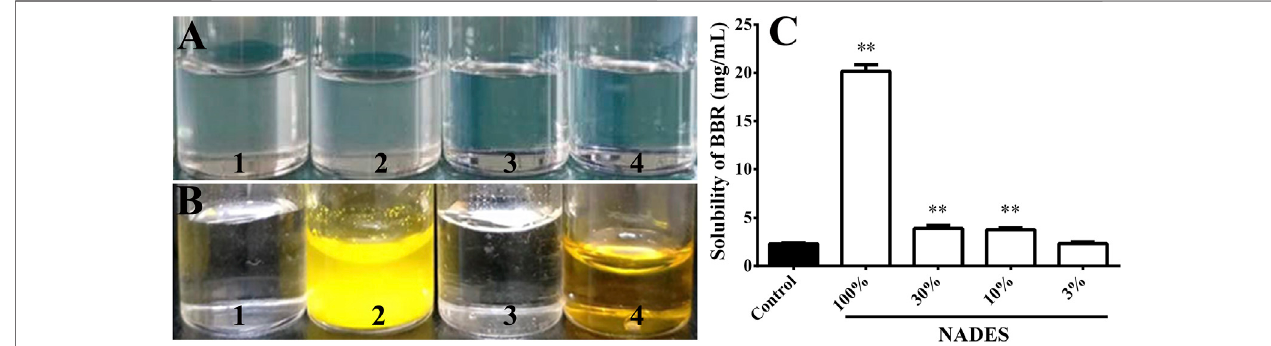
FIGURE2| Stabilityanddissolvingcapacityofthepreparednaturaldeepeutecticsolvents(NADESs)(Mean ± SD, n (cid:2) 4). (A) ,theNADESsthatwereplacedatroom temperature (20 ° C) for 48 h after preparation. One to four, NADESs prepared by the addition of 250, 300, 350, or 400 μ L of water to 1,307.8 mg of the mixture of malic acid (490.5 mg), glucose (280.6 mg), sucrose (517.7 mg), and choline (19.0 mg), respectively. (B) , dissolving capacity of the NADES prepared with 350 μ L of water on berberine hydrochloride (BBR) at room temperature (20 ° C). One to four, water, BBR (20 mg/ml) dissolved in water, the NADES, and BBR (20 mg/ml) dissolved in the NADES, respectively. (C) , dissolving capacity of the NADES (100%) or its water dilutions (30, 10, and 3%) on berberine hydrochloride (BBR) at room temperature (20 ° C). **, p < 0.01 vs. control.